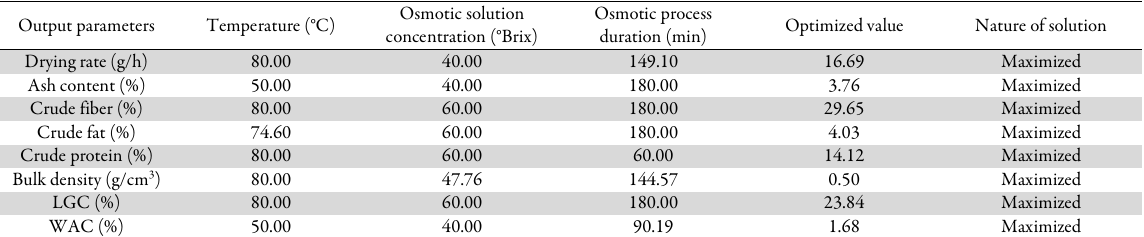
Osmotic solution concentration (°Brix)